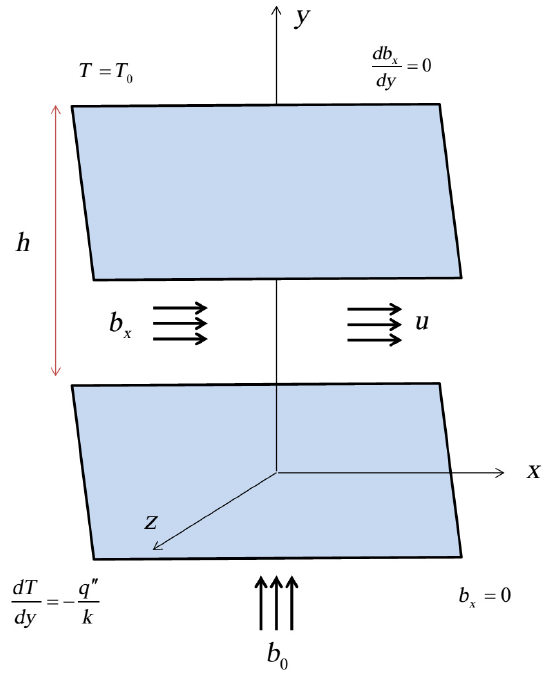
Figure 1. Geometry of the problem. Table 1. Constants of Al 2 O 3 − Water [27].